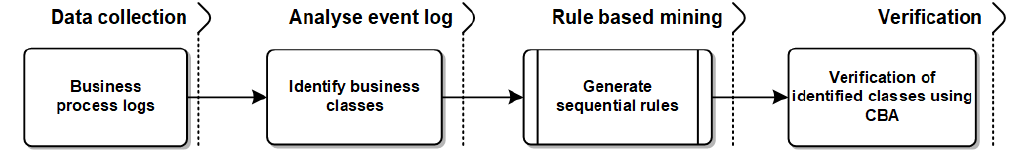
Figure 6. Implementation model for the stage-1.